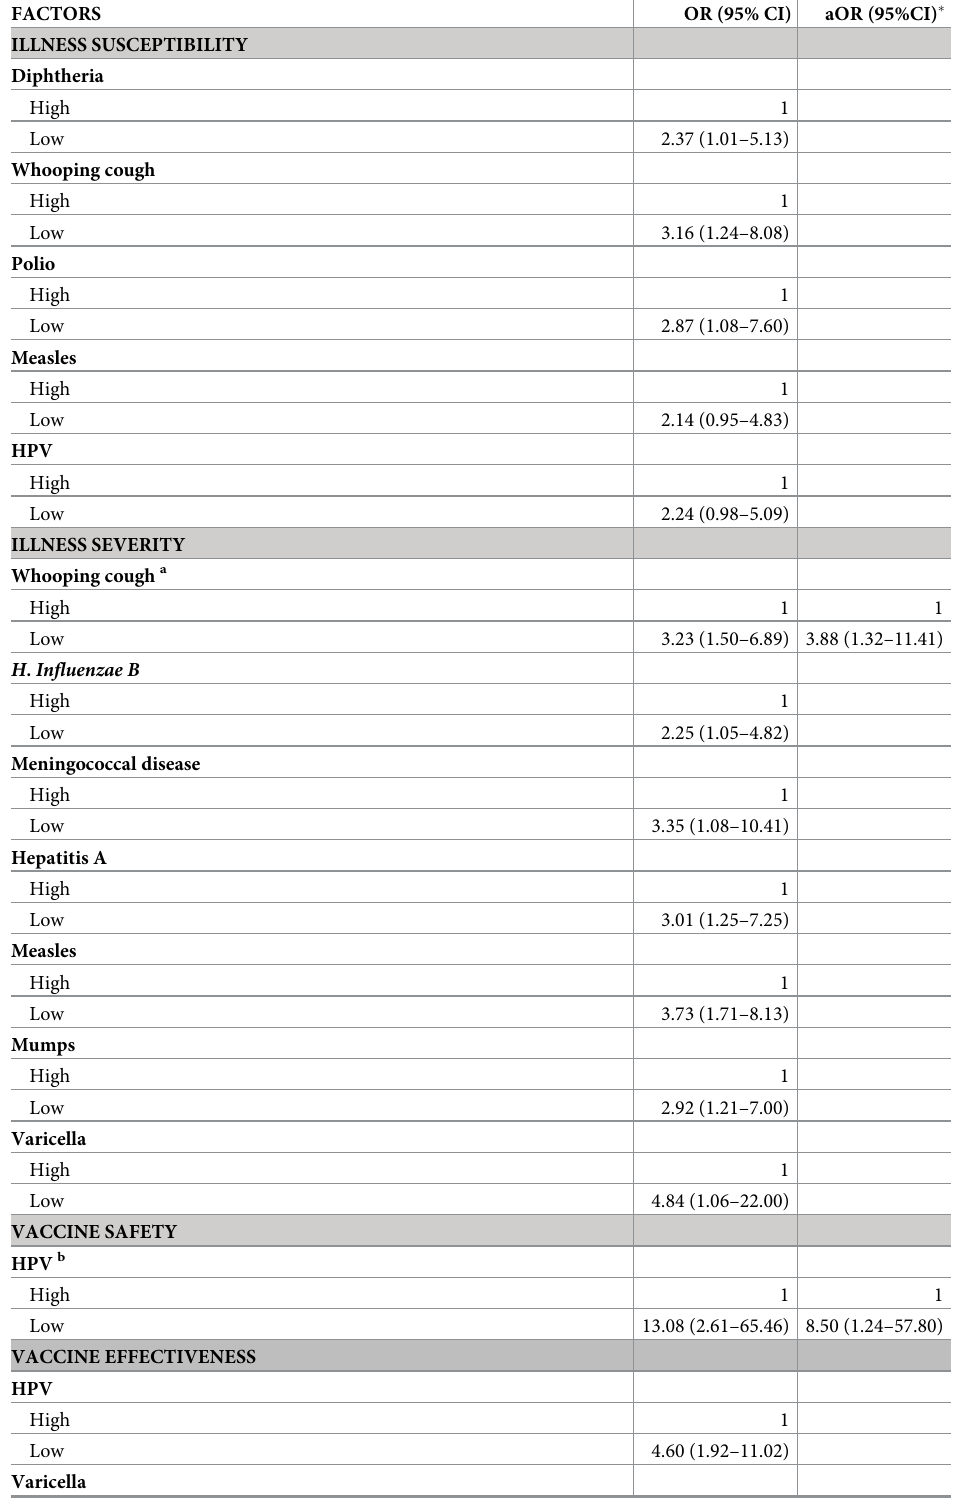
Table 4. Factors associated to vaccine hesitancy in paediatric nurses of PHC. Barcelona.